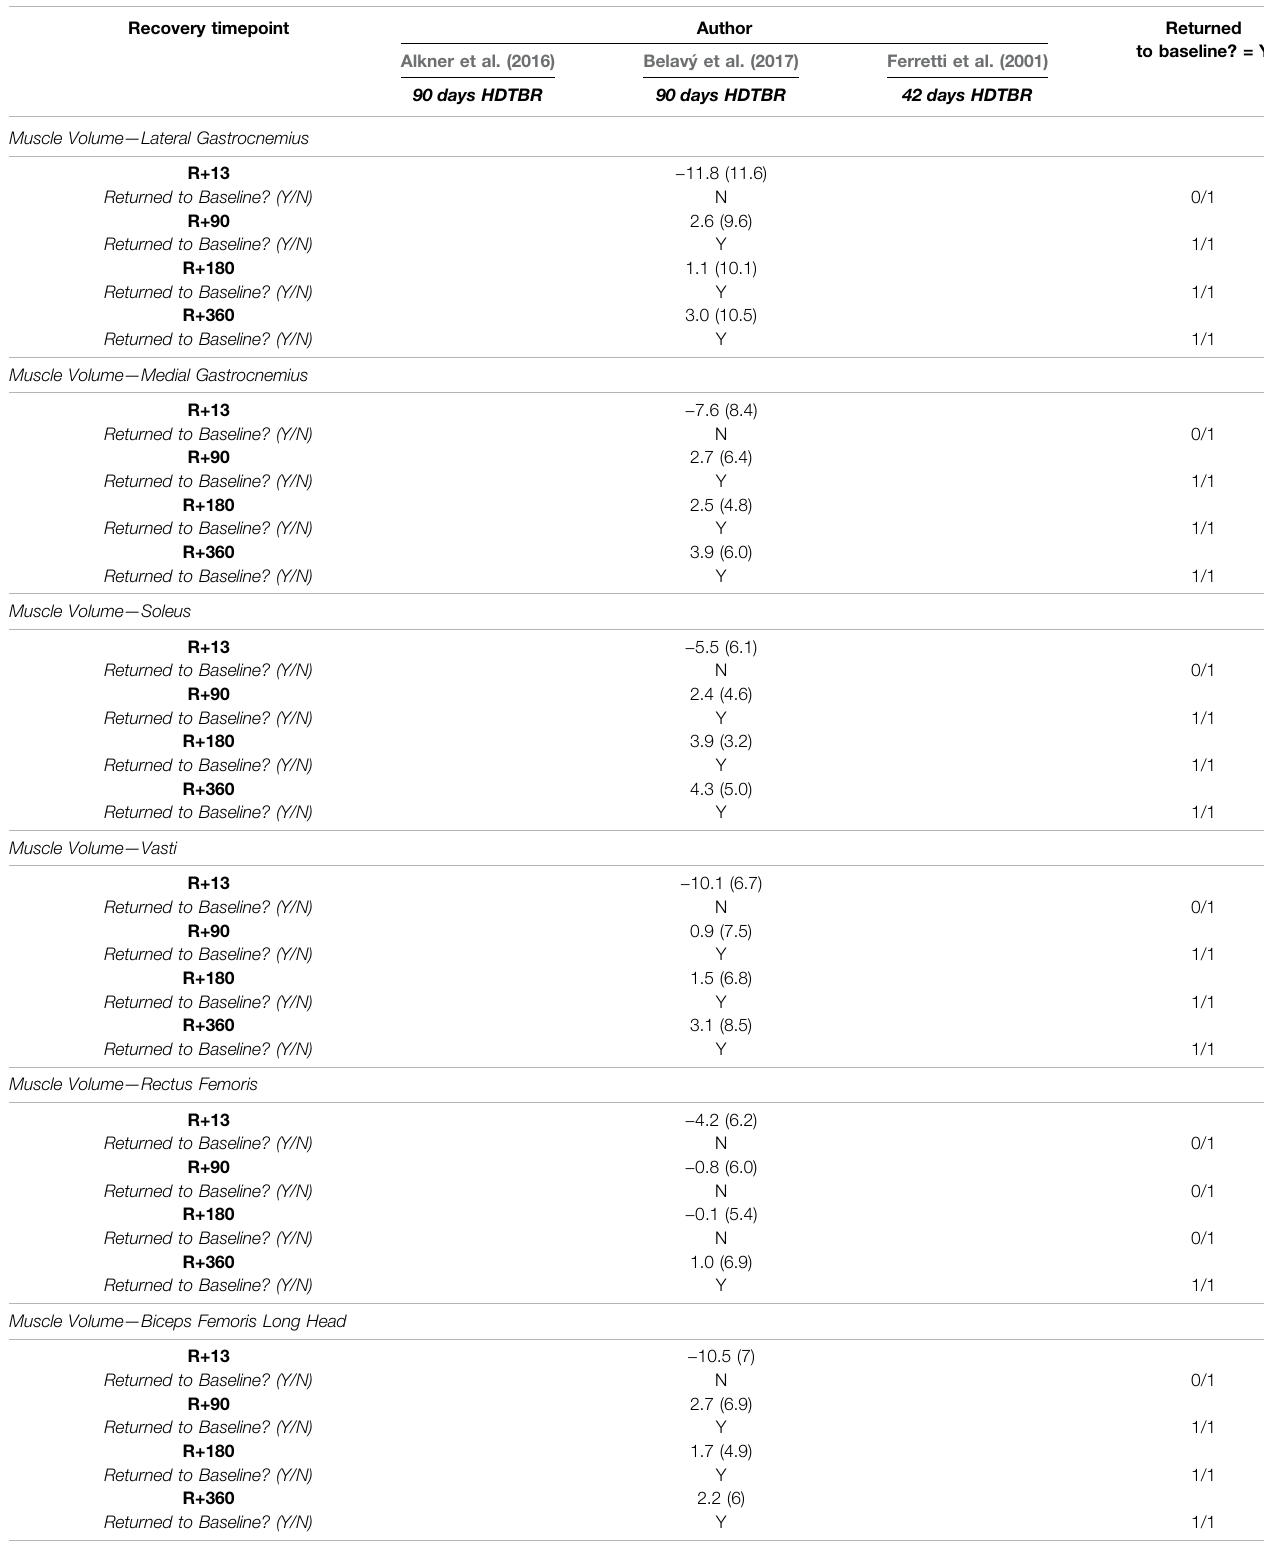
TABLE 5 | % Change with SD of outcome parameters related to the ‘ Muscular System ’